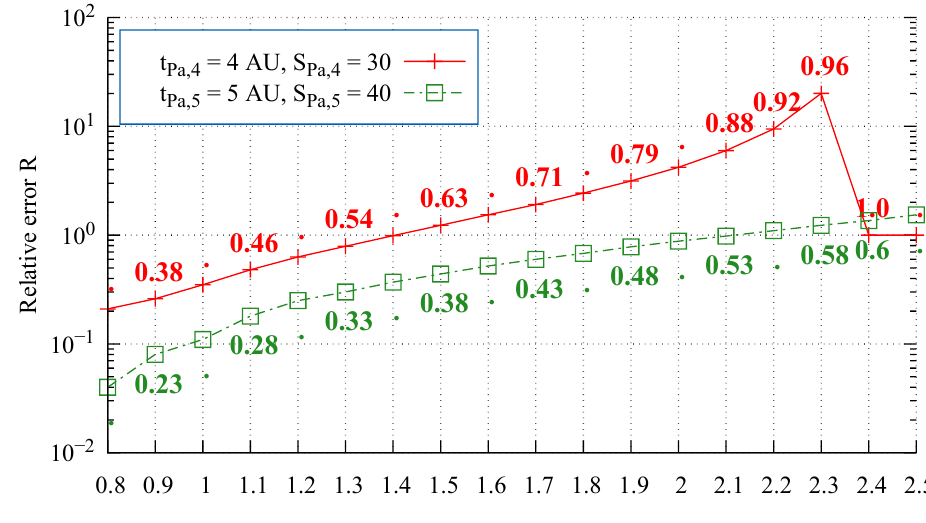
Figure 6. Relative error of the average value of overflow traffic, System 2, Resource 2 ( α values specified directly in the